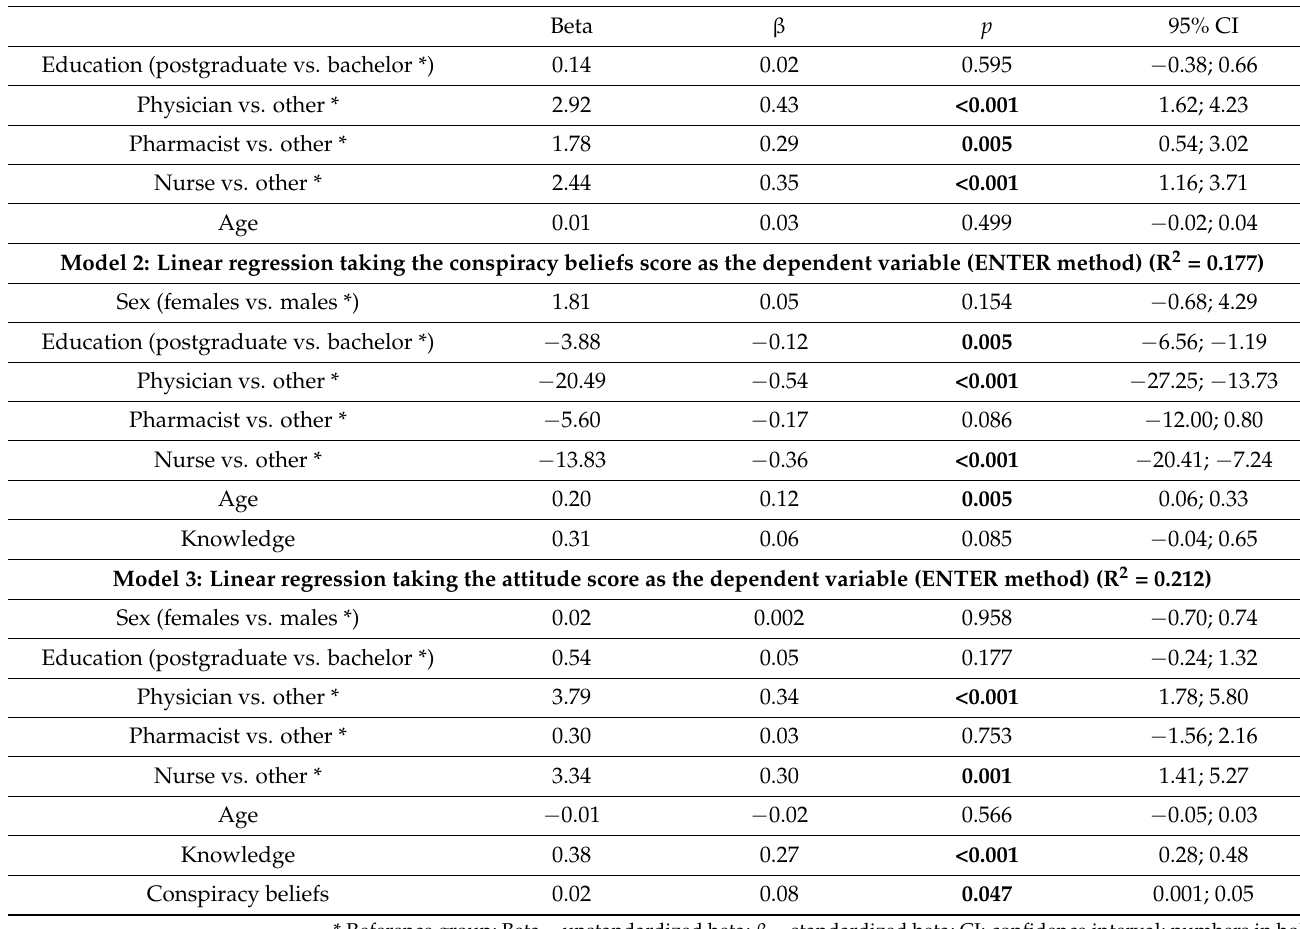
Table 7. Multivariable